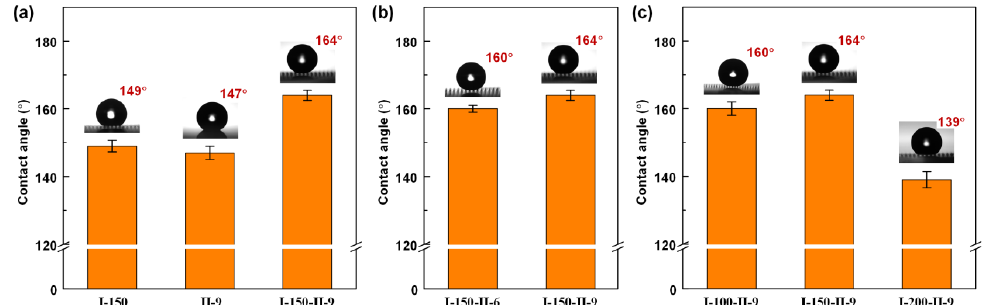
Figure 3. Contact angles of different PDMS films: ( a ) single primary structure I-150, single secondary structure II-9, and corresponding hierarchical structure I-150-II-9, ( b ) hierarchical structures with different secondary micropillar center distances, ( c ) hierarchical structures with different primary micropillar center distances.